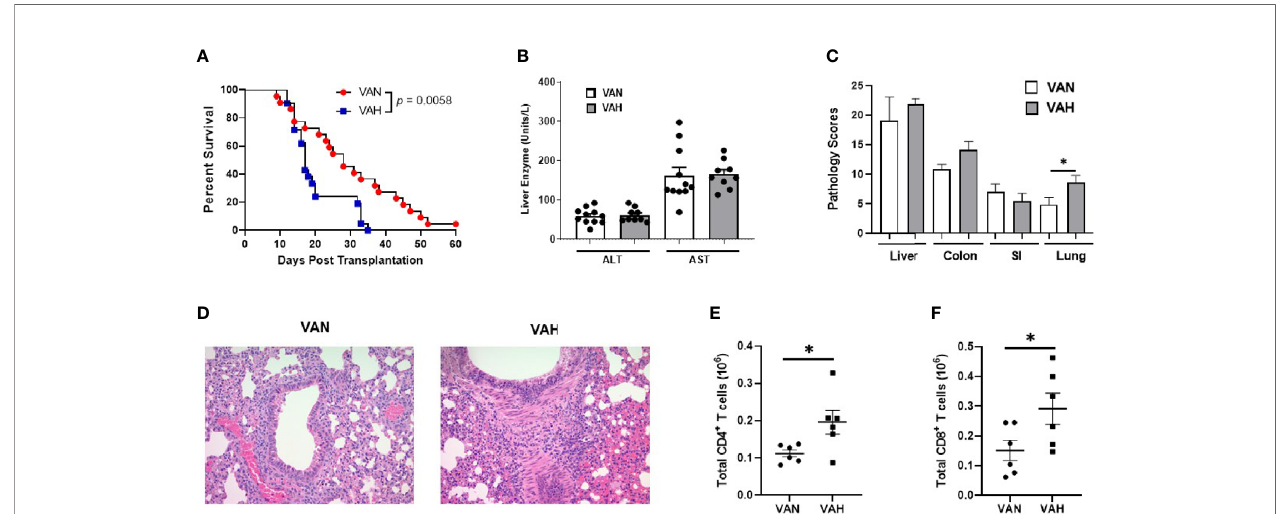
FIGURE 4 | Recipient mice fed a diet high in vitamin A show more severe lung GVHD after allogeneic BMT. (A) Lethally irradiated VAN and VAH mice were transplanted with BM (7 – 8 x 10 6 ) plus 0.4 x 10 6 puri fi ed T cells from B6 mice. Overall survival is depicted. Data are the cumulative results from 7 independent experiments (n = 21 – 22 per group). (B) Serum liver enzymes in VAN and VAH recipients 7 days after transplantation. Data are shown as Mean ± SEM and are cumulative results from three independent experiments (n = 9 – 11 per group). (C) Recipient mice were euthanized on day 14 after BMT and pathologic damage in the liver, lung, small intestine, and colon was examined. Data are derived from one representative experiment (n = 5 per group). (D) Representative photo micrographs of the lungs from VAN and VAH mice are shown. (E, F) The absolute numbers of donor H ‐ 2 b+ CD4 + T cells (E) and donor H ‐ 2 b+ CD8 + T cells (F) in the lungs of recipient mice were examined. Data are shown as Mean ± SEM and are cumulative results from two experiments (n = 6 per group). Statistics: * P ≤